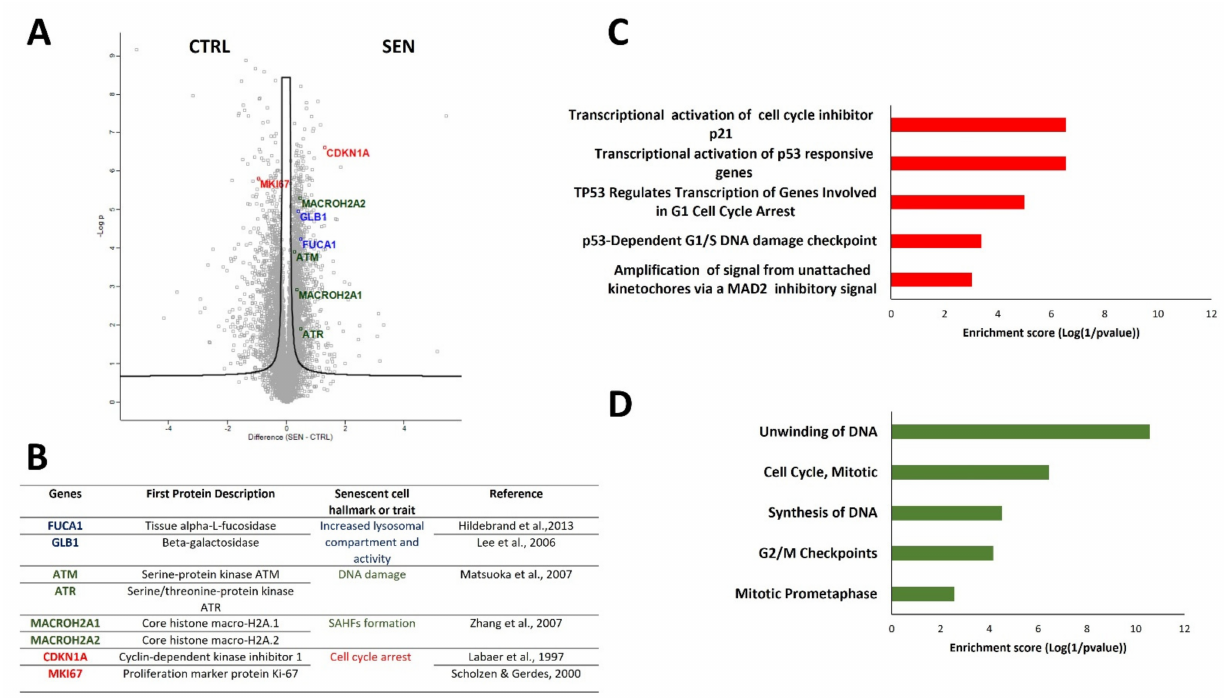
Figure 2. ( A ) Volcano plot representing the statistical comparison of the protein LFQ intensities of H 2 O 2 treated cells versus untreated controls. The abscissa reports the fold change in logarithmic scale (difference), and the ordinate − log(p) of t -tests (FDR = 0.05, s0 = 0.1). Deregulated senescent protein markers have been highlighted in different colours in the volcano plot and described in detail in the related table [23,24,26–29] ( B ). ( C ) Reactome enrichment analysis of the most upregulated and downregulated ( D ) proteins (FDR = 0.05, s0 = 1) in H 2 O 2 treated cells. In both cases, only the main five pathways have been reported ( p <